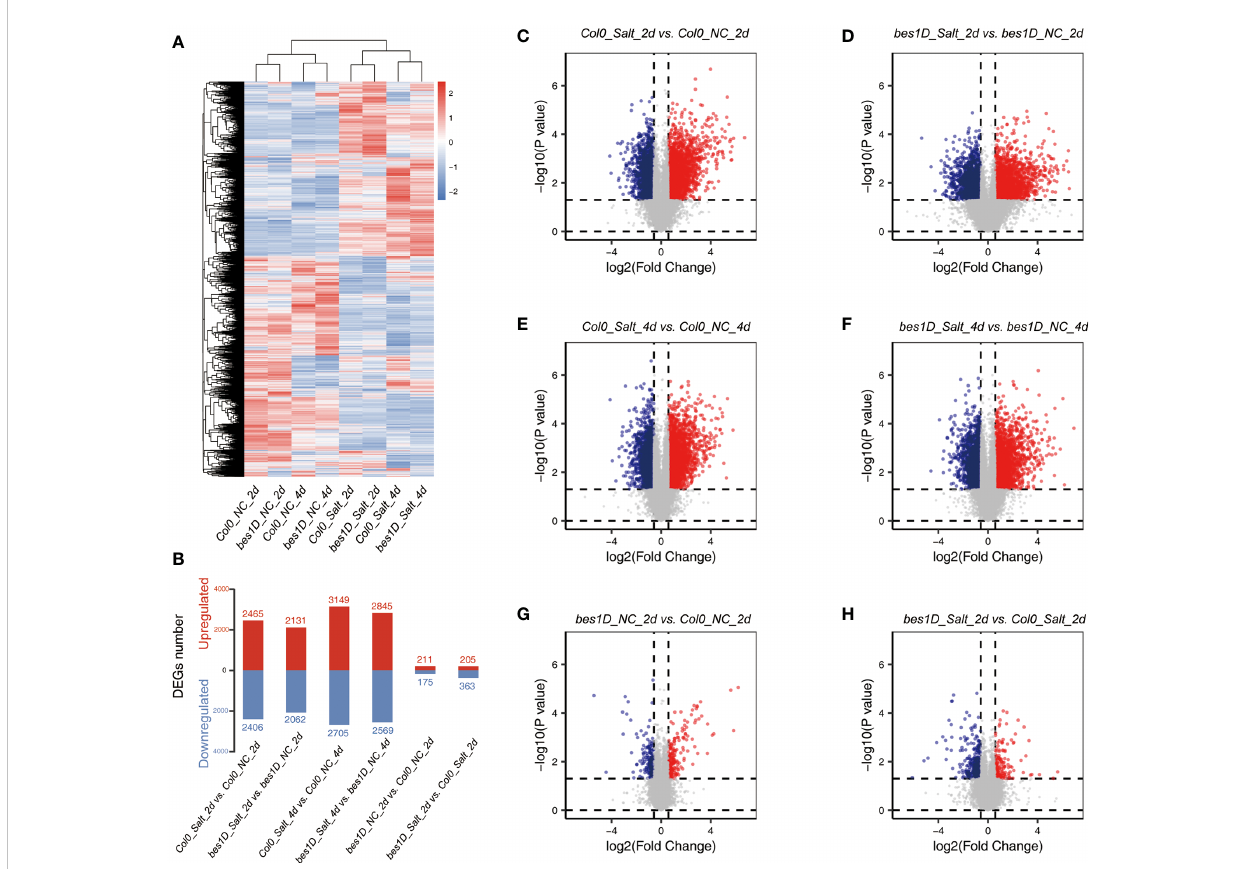
FIGURE 3 Transcriptomic analyses in bes1-D and Col-0 under salt stress. (A) Heatmap of genes in eight experimental groups. A total of 13,528 genes with average FPKM > 5 were used for this analysis. FPKM values were transformed by Z-score = (FPKM − mean)/ s . Hierarchical cluster based on Euclidean Distance was used for the clustering analysis. NC, normal condition, or negative control; Salt, 150 mM NaCl. (B) DEGs numbers in different comparisons. Fold change (absolute value) > 1.5 and P value < 0.05 were regarded as DEGs. Red, upregulated genes; blue, downregulated genes. (C – H) Volcano plot of all expressed genes in different comparisons. Red, signi fi cantly upregulated genes; blue, signi fi cantly downregulated